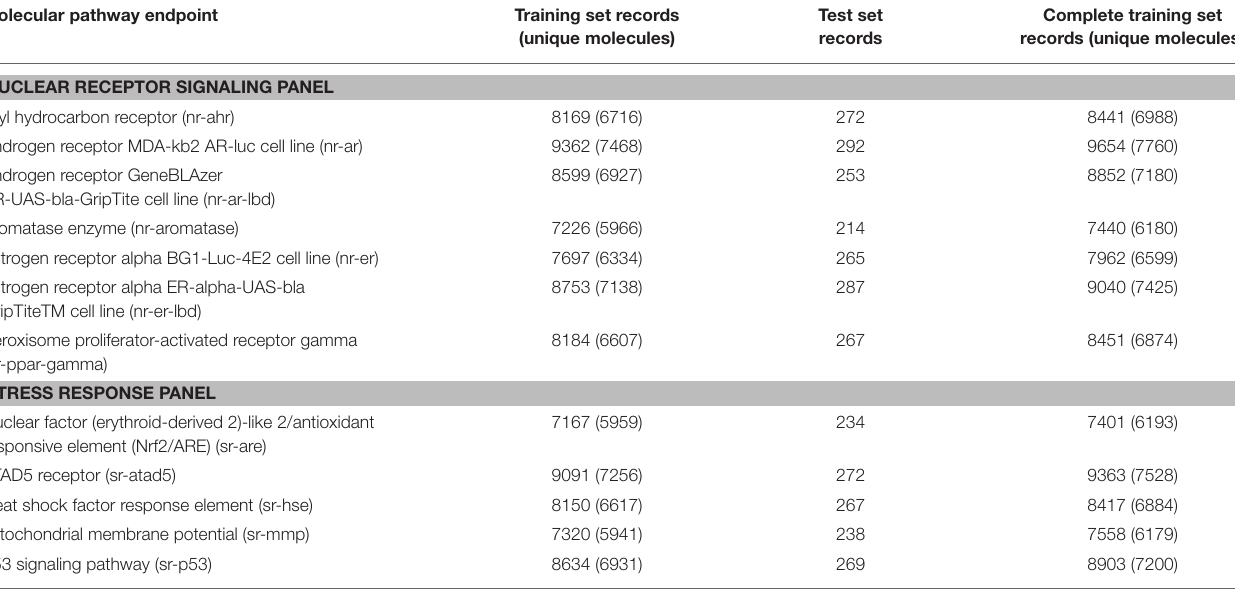
TABLE 1 | Number of records and unique molecules in each dataset. Molecular pathway